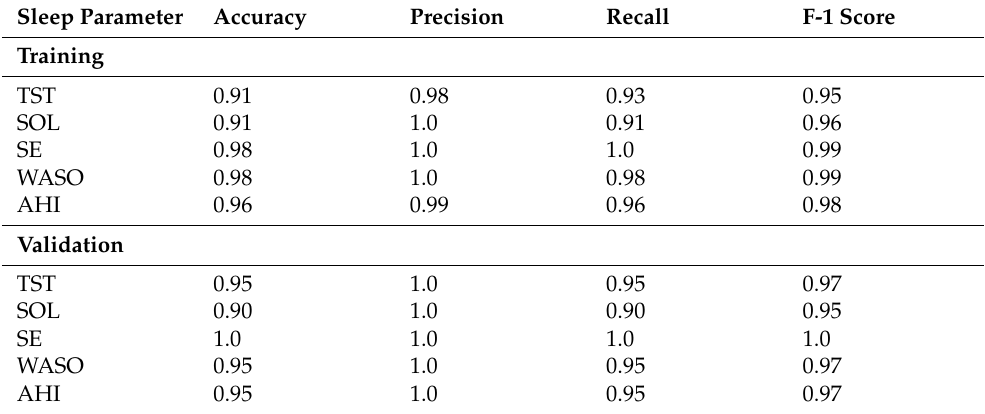
Table 2. Performance analysis of the NLP